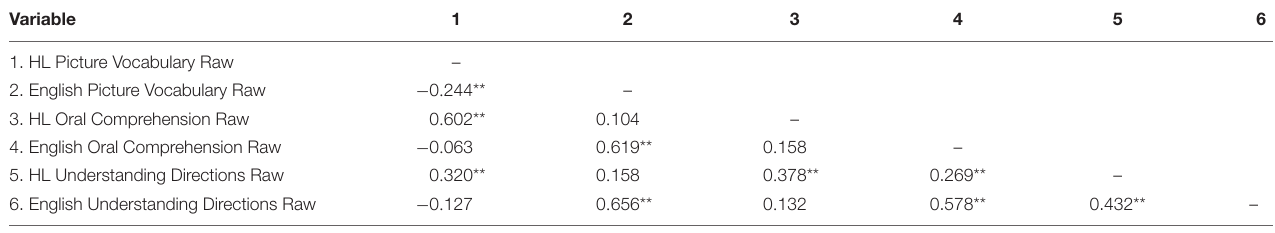
TABLE 5 | Correlations among the oral language variables.